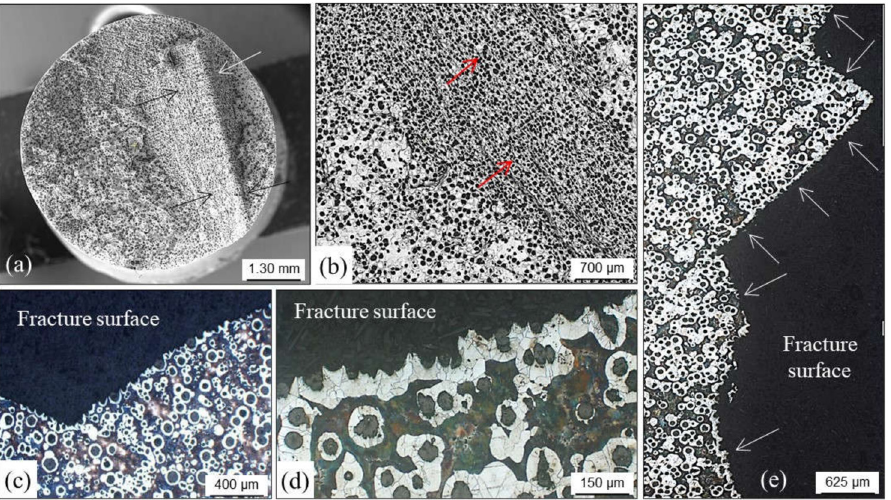
Figure 85. SEM views of a fracture surface with alignments of graphite nodules ( a , b ). Cross sections of the fractured surfaces showing the plates originated by alignments ( c – e